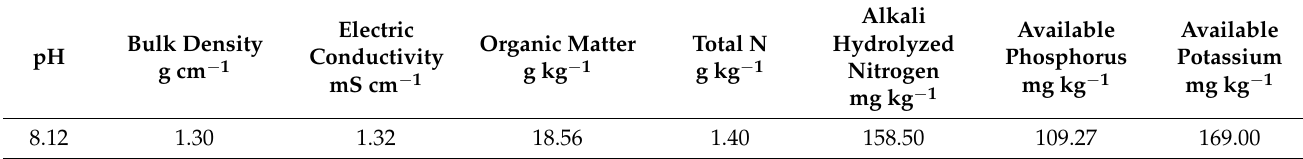
Table 1. The basic soil